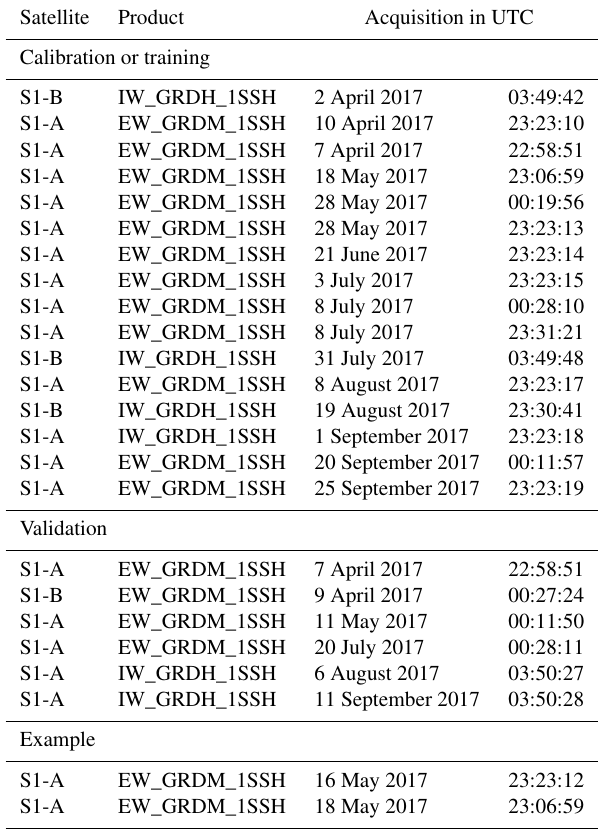
Table 2. List of used S1-A/B swaths for calibration or training, val- idation, and a detailed analysis (Fig.